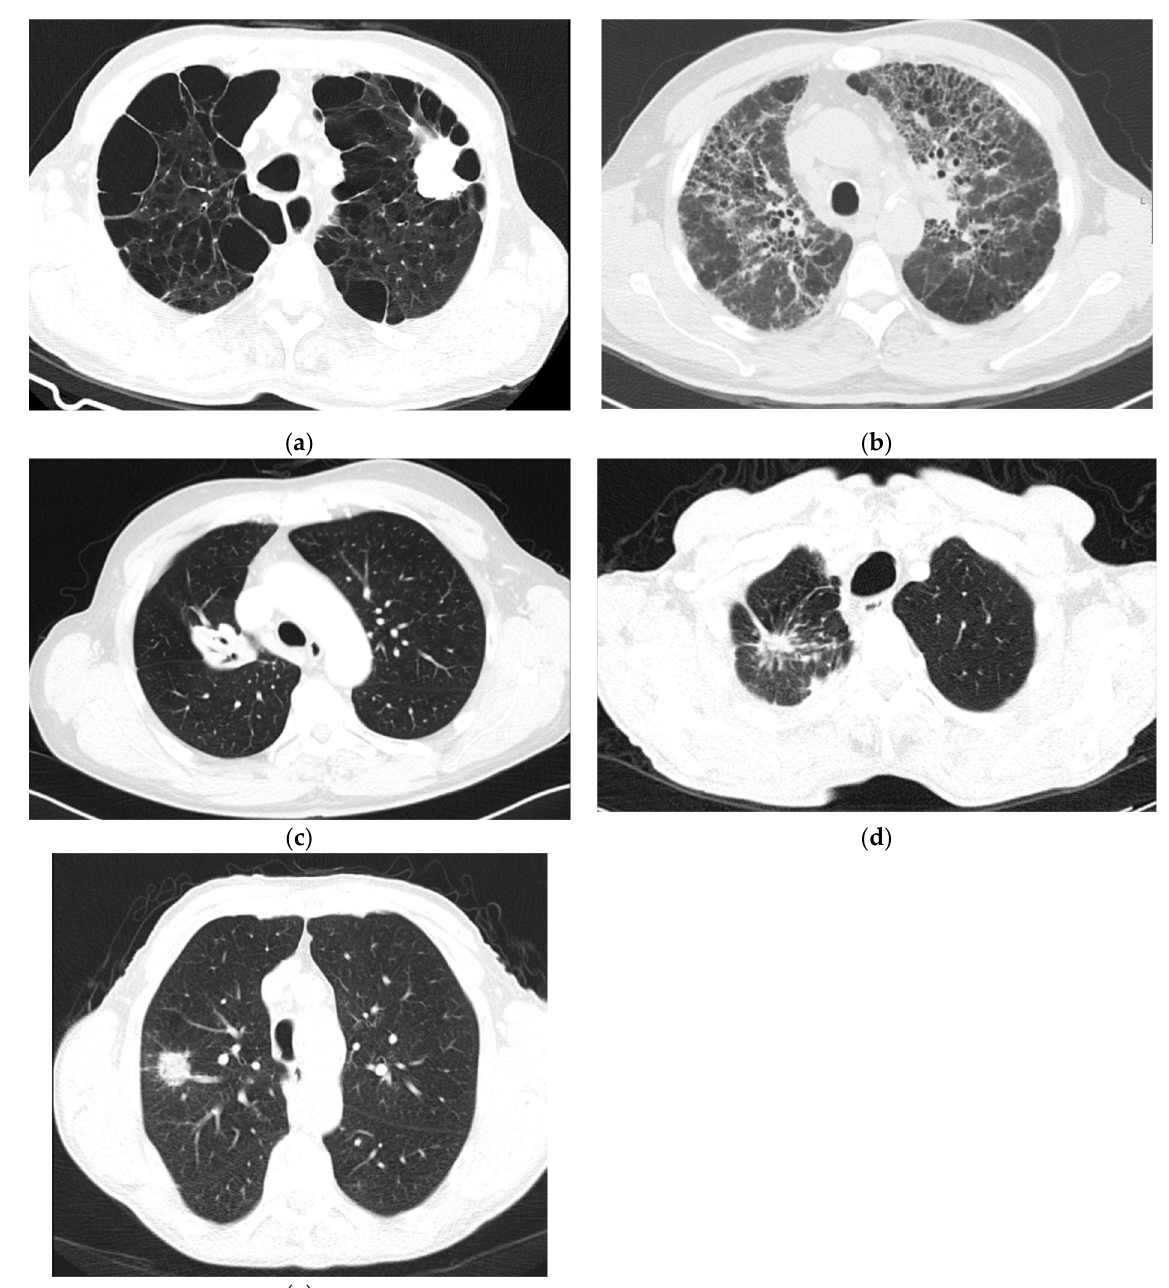
Figure 1. A set of axial computed tomography (CT) images with findings related with lung cancer pathogenesis: ( a ) cen- trilobular emphysema; ( b ) pulmonary-fibrosis; ( c ) air bronchogram; ( d ) pleural retraction; and, ( e ) vascular convergence.